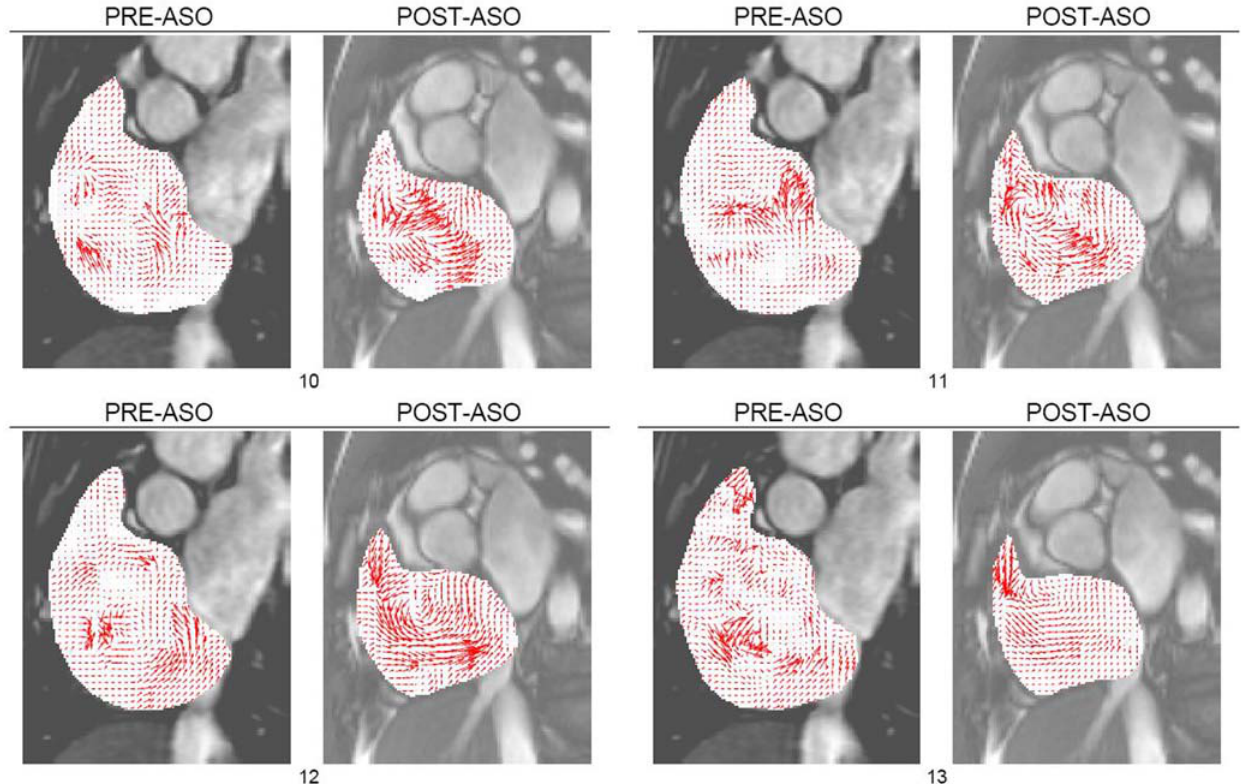
Figure 2. MR fluid motion flow fields of right atrium. The motion field of blood can be produced rapidly by using MR fluid motion tracking to give an estimation of the direction and magnitude of flow. The method can give a quick insight into the fluid flow behavior, and the swirling of blood based on cardiac phases at frames n t =[10, 11, 12, 13] can be observed more clearly after atrial septal occlusion. The swirling traced within the chamber region of interest shows the existence of vortices.